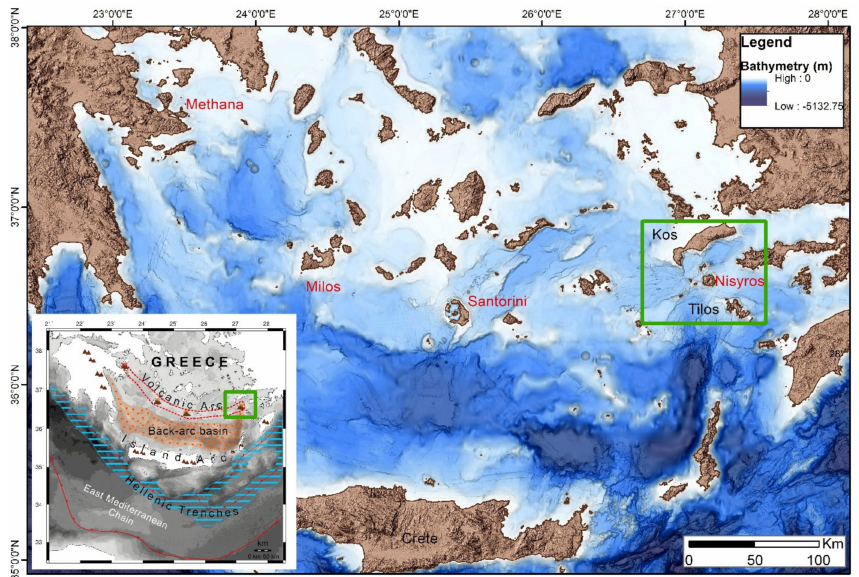
Figure 1. The four volcanic groups of the Aegean volcanic arc (in red) and the studied area (in green frame). Kos and Tilos islands border the neotectonic graben of the Nisyros volcanic field (modified from 27). Insert map: Simplified map of the present day geodynamic structure of the Hellenic Arc, showing the modern Aegean volcanic arc developed behind the Hellenic trench, the Peloponnese-Crete island arc and the Cretan Back-arc basin (modified from